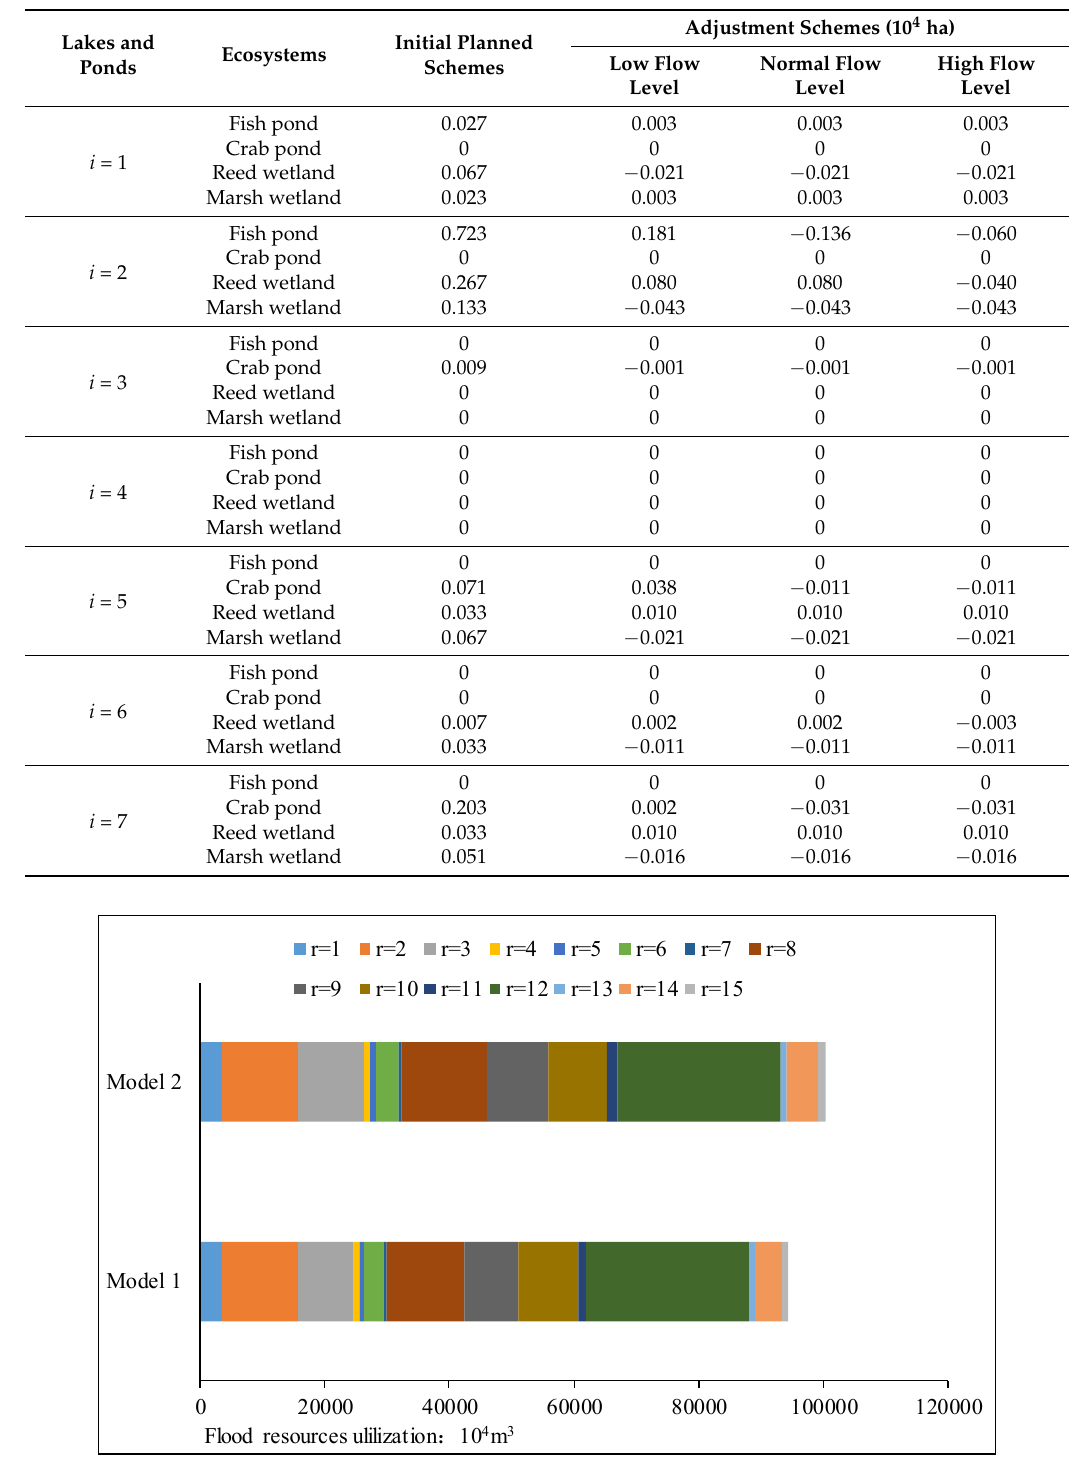
Figure 14. Comparison of flood resource utilization based on two optimal models under the high‐flow scenario.